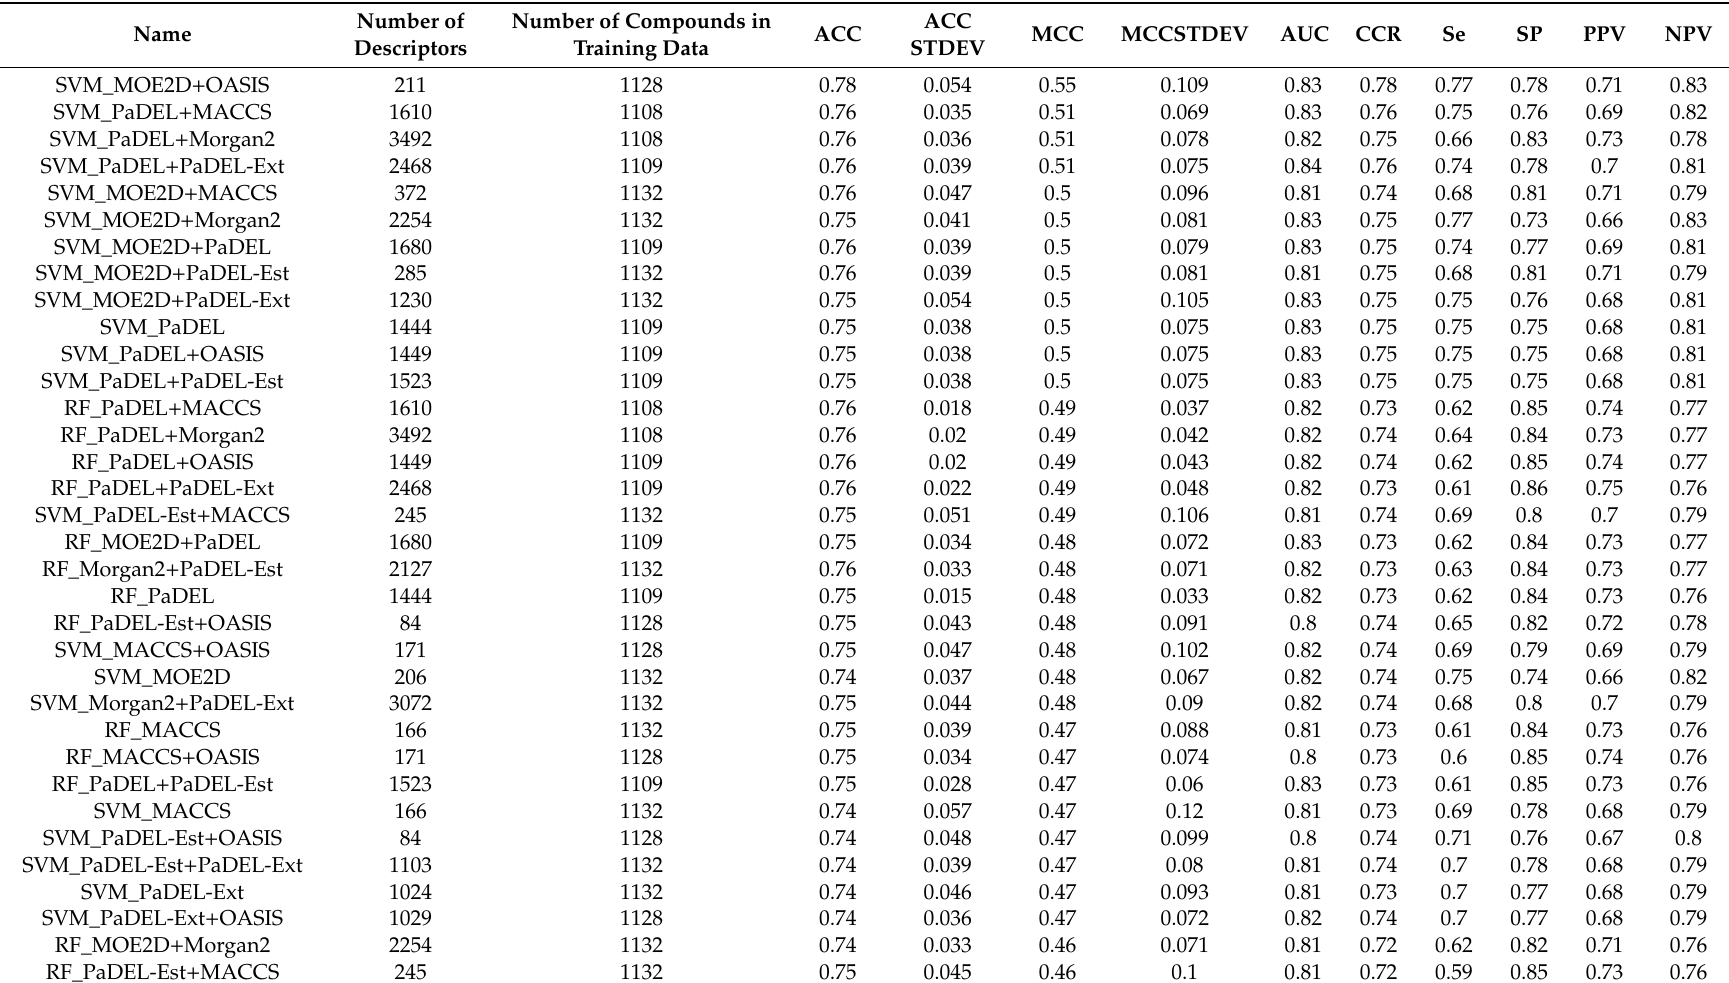
Table 4. Overview of models and their performance during